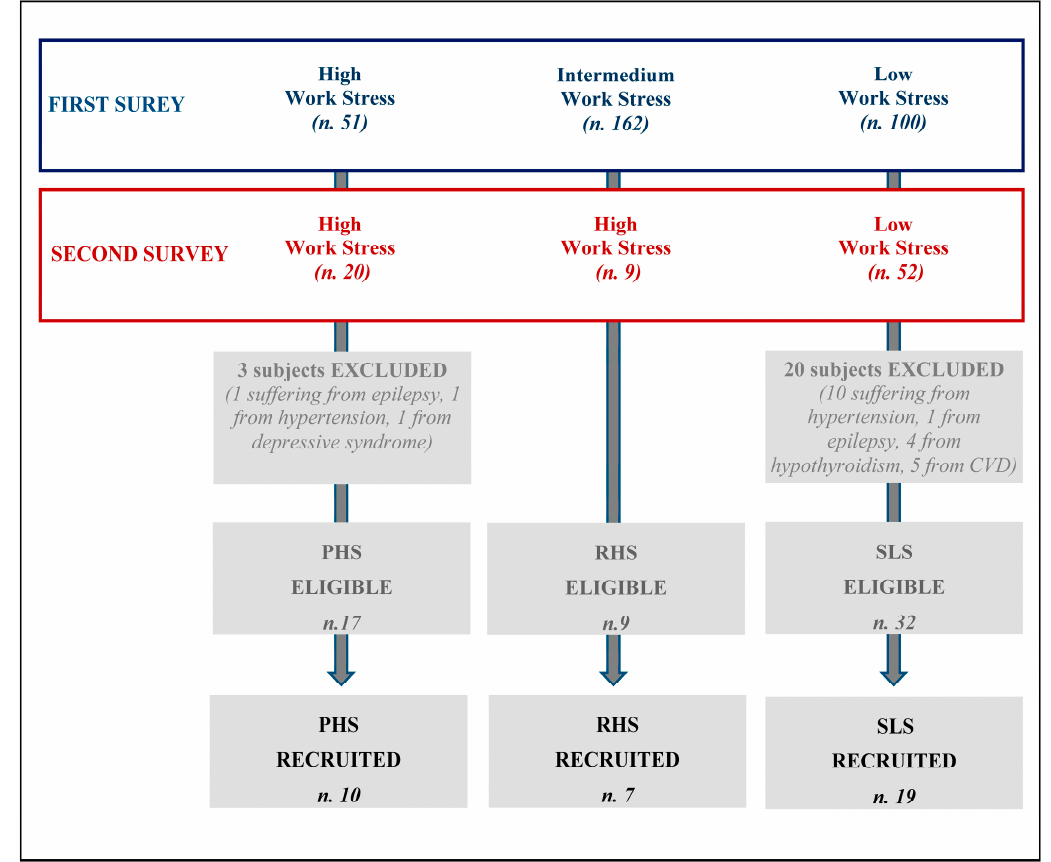
Figure 1. The flow-chart shows the selection of enrolled sample and the application of the exclusion criteria to each chronic work stress categories.